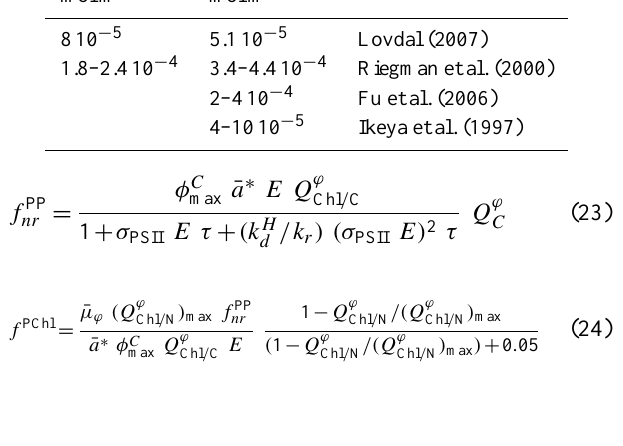
One aspect is that respiration rate will increase with increas- ing carbon intracellular content and this conveys the idea that respiration rate may be higher during the day, a feature that has been observed in natural communities (Weger et al.,